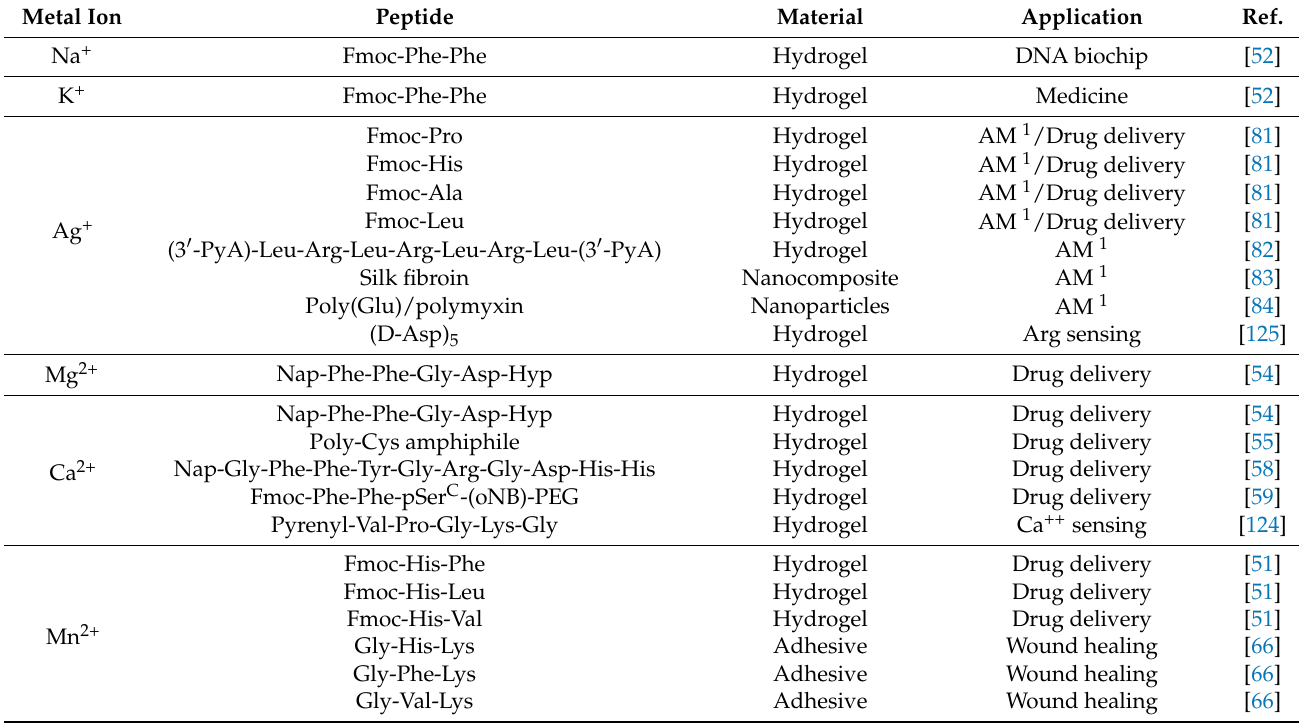
Table 1. Summary of metal–peptide-based materials discussed in this